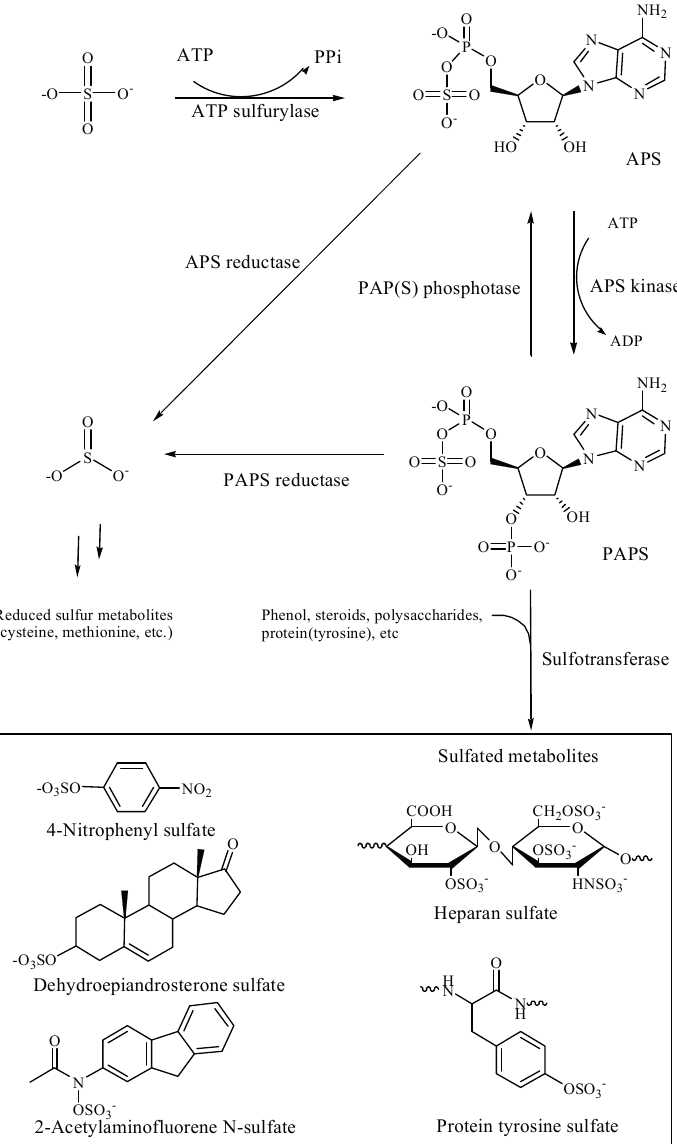
Figure 1. Activation of inorganic sulfate and its assimilation in biological systems. The inorganic sulfate is activated in the forms of adenosine-5'-phosphosulfate (APS) and 3'-phospho-adenosine-5'-phosphosulfate (PAPS) by ATP sulfurylase and APS kinase, respectively. Sulfotransferases are known to be responsible for the transfer of activated sulfate to a variety of biological molecules. Alternately, activation of sulfate serves as a route for the reduction and assimilation of the inorganic sulfate into important amino